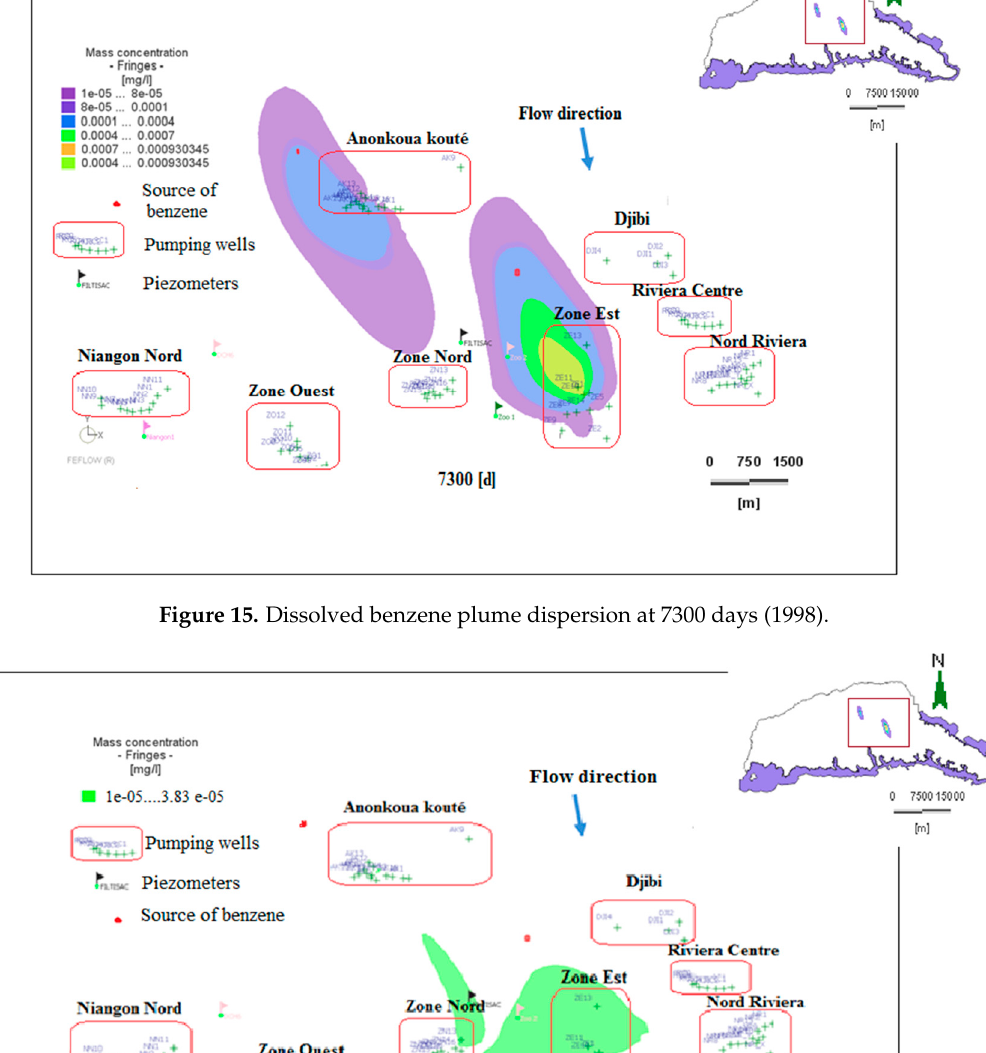
Figure 14. Dissolved benzene plume dispersion at 1825 days (1983).